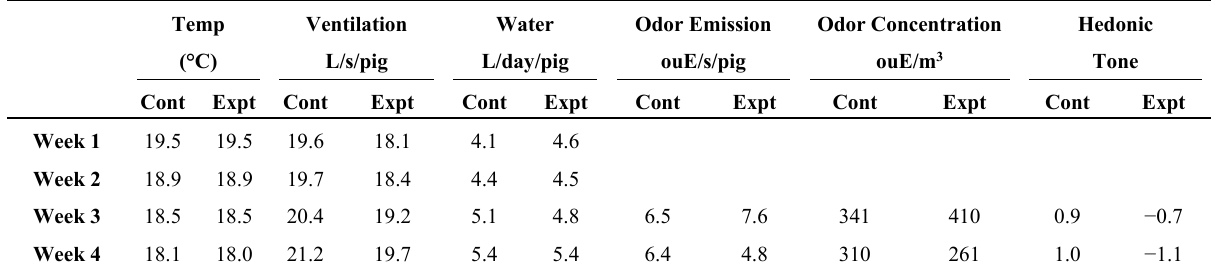
Table 6. Effect of control and experimental diet on environmental parameter values.